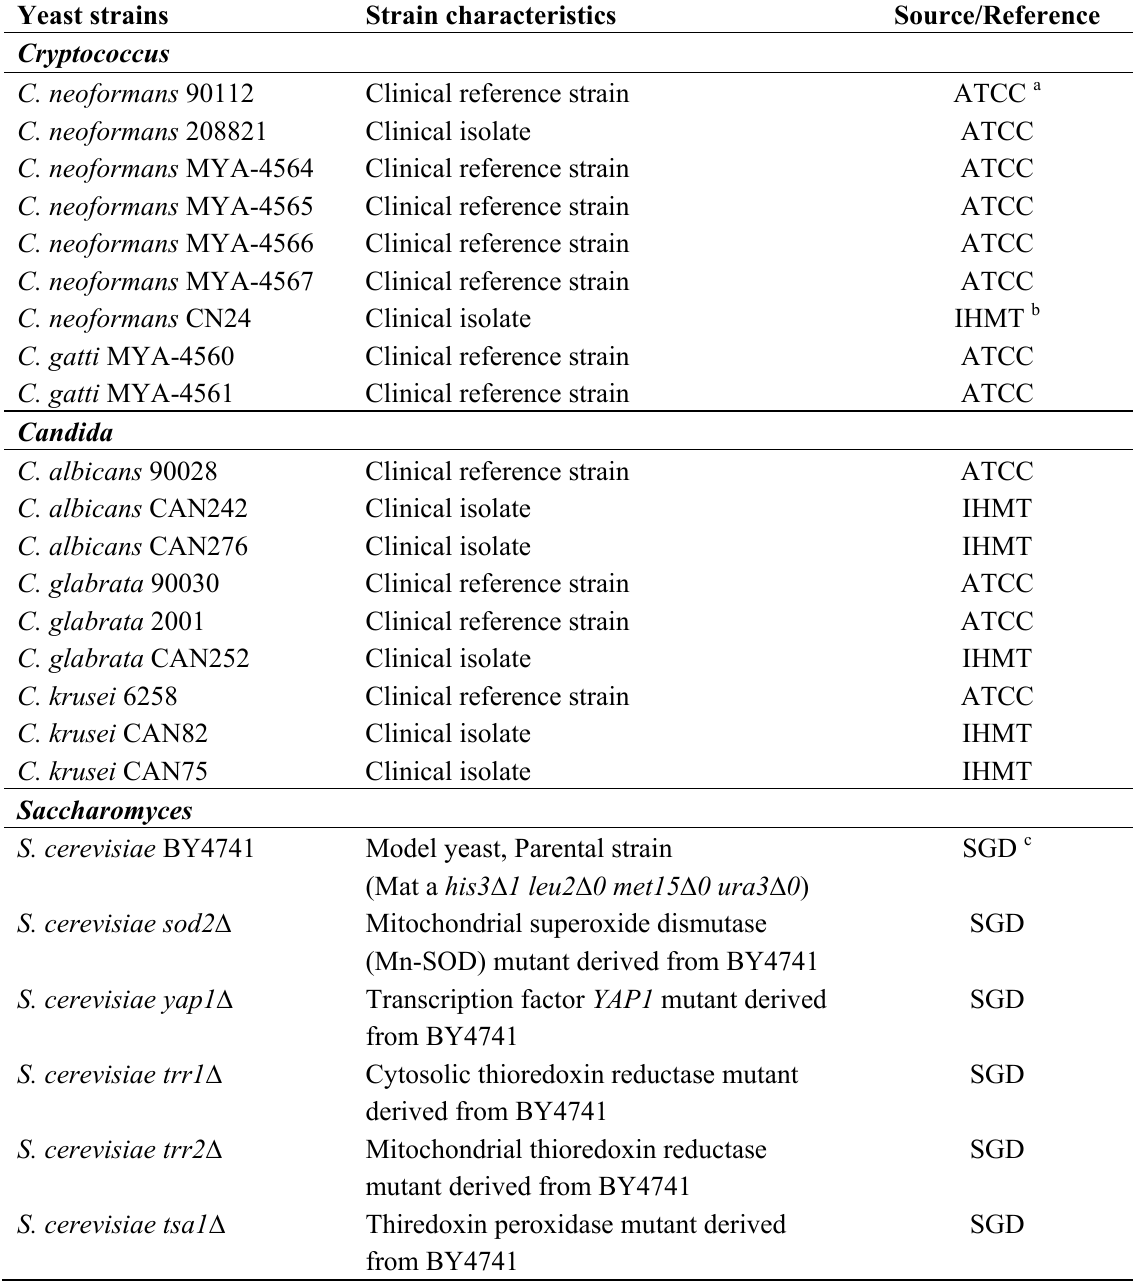
Table 2. Yeast strains used in this